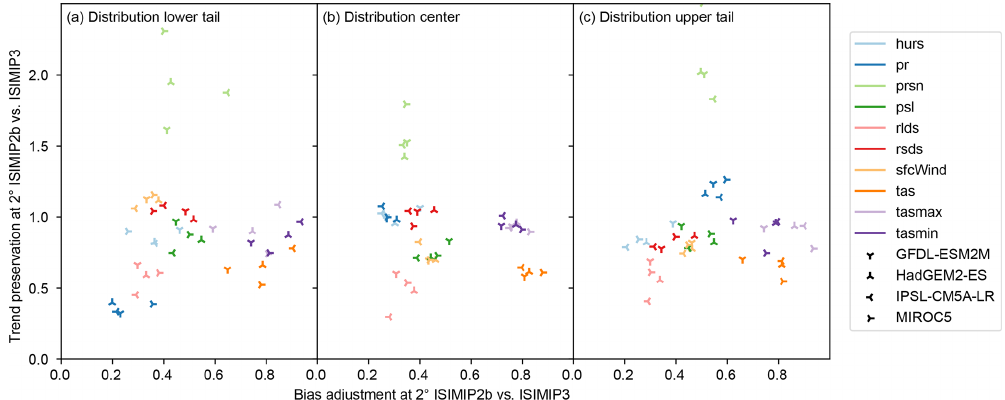
Figure 7. Goodness of bias adjustment ( x axis) and trend preservation ( y axis) by the ISIMIP2b and ISIMIP3 bias adjustment methods for the lower tail (a) , center (b) , and upper tail (c) of the distribution of daily values of 10 different climate variables (color, Table 1) simulated by four different climate models (symbols) at 2 ◦ spatial resolution. Values on both axes represent ratios of spatiotemporally aggregated absolute errors after bias adjustment with the two methods (see Sect. 3.3). Values greater than 1 indicate better bias adjustment or trend preservation by the ISIMIP2b method than by the ISIMIP3 method and vice versa for values smaller than 1.